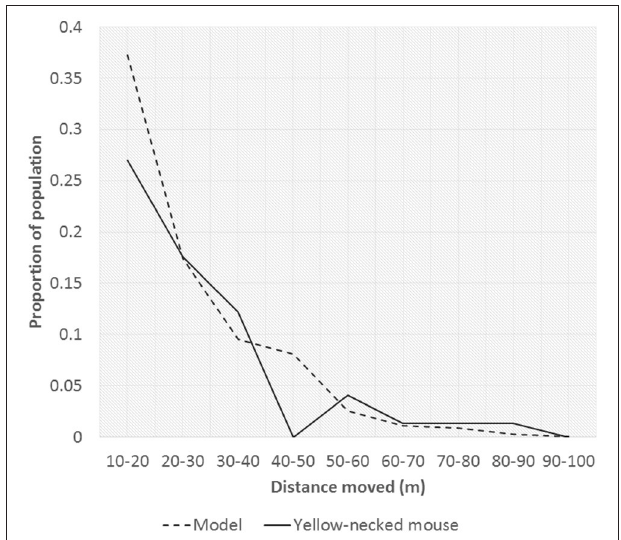
FIGURE 1 | Yellow-necked mouse dispersal distances and fitted diffusion